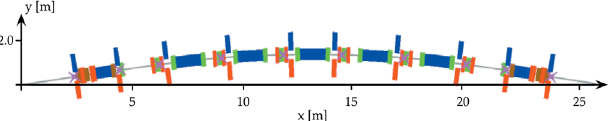
FIG. 1. MAX IV 3 GeV storage ring lattice. Magenta crosses indicate the positions of BPMs, while the blue and orange stripes are the positions of the dipole correctors. In the case of the vertical dipole correctors the second corrector in the image is not present.